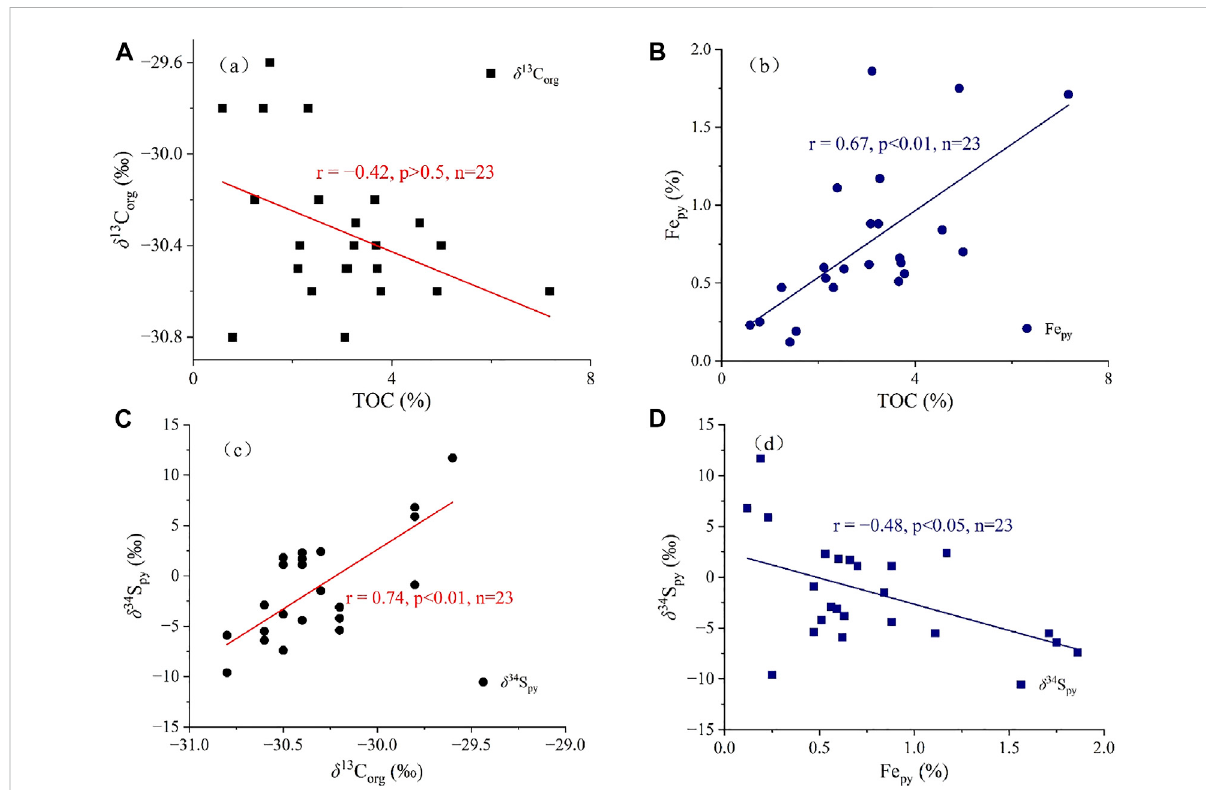
FIGURE 3 Crossplots of TOC vs. (A) δ 13 C org and (B) Fe py , crossplots of (C) δ 13 C org and (D) Fe py vs. δ 34 S py . All fi tting curves are